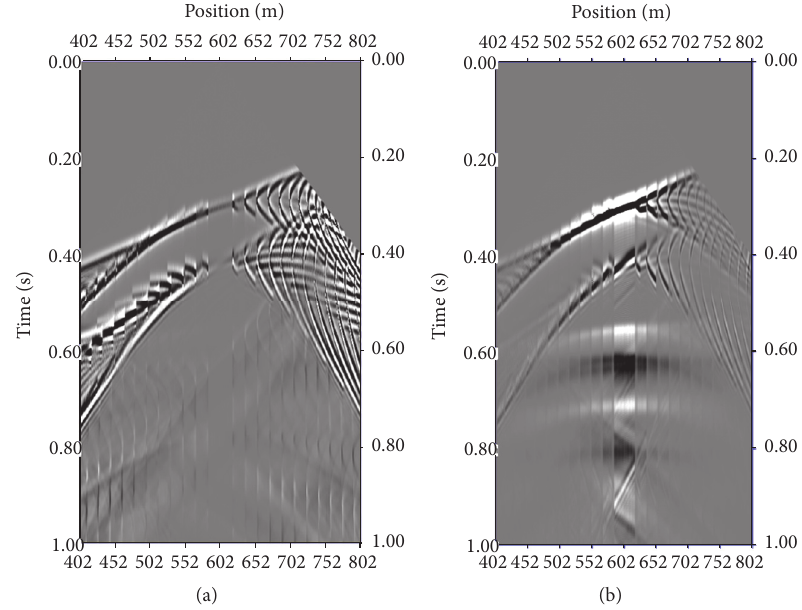
Figure 11: The CSP gather at 600 m using the algorithm for horizontal surface assumption; (b) the CSP gather at the same point using the algorithm for the rugged